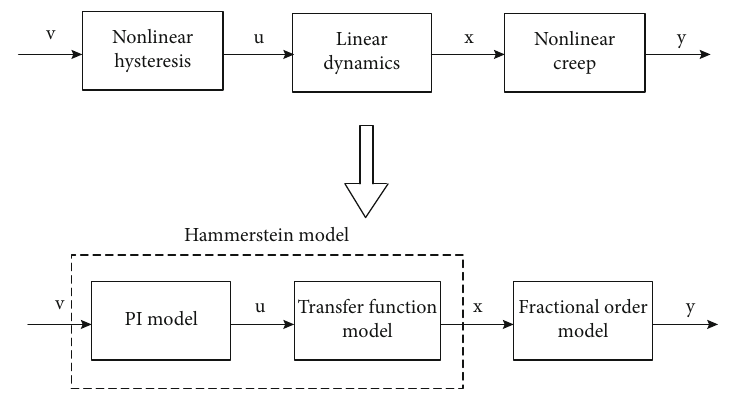
Figure 1: The proposed coupling structure model.